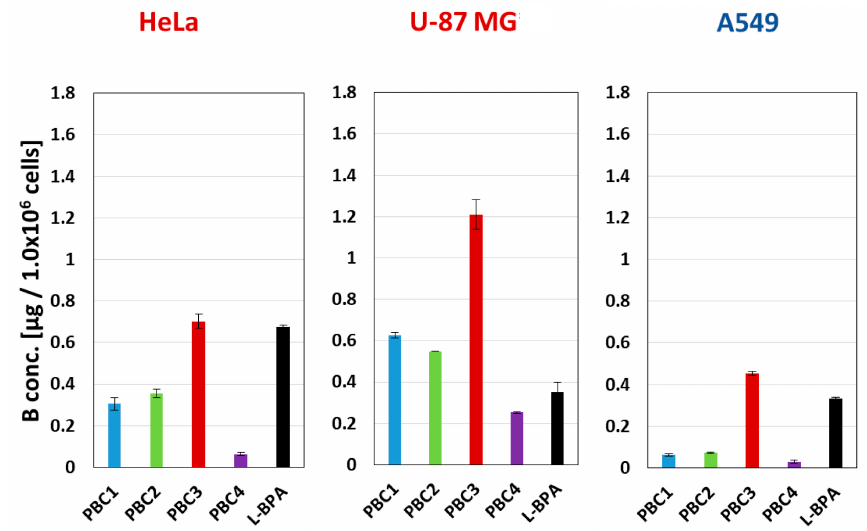
Figure 2. Boron accumulation of PBCs 1–4 into HeLa, U87MG, and A549 cells. The cells (1 × 10 6 cells) were incubated at 37 °C for 3 h in a medium containing boron compounds (100 ppm B). After incubation, the cells were washed three times with PBS and digested with 2 mL of perchloric acid/hydrogen peroxide at 70 °C for 1 h. Boron concentrations in the solution were determined by an inductively coupled plasma optical emission spectroscopy (ICP-OES).